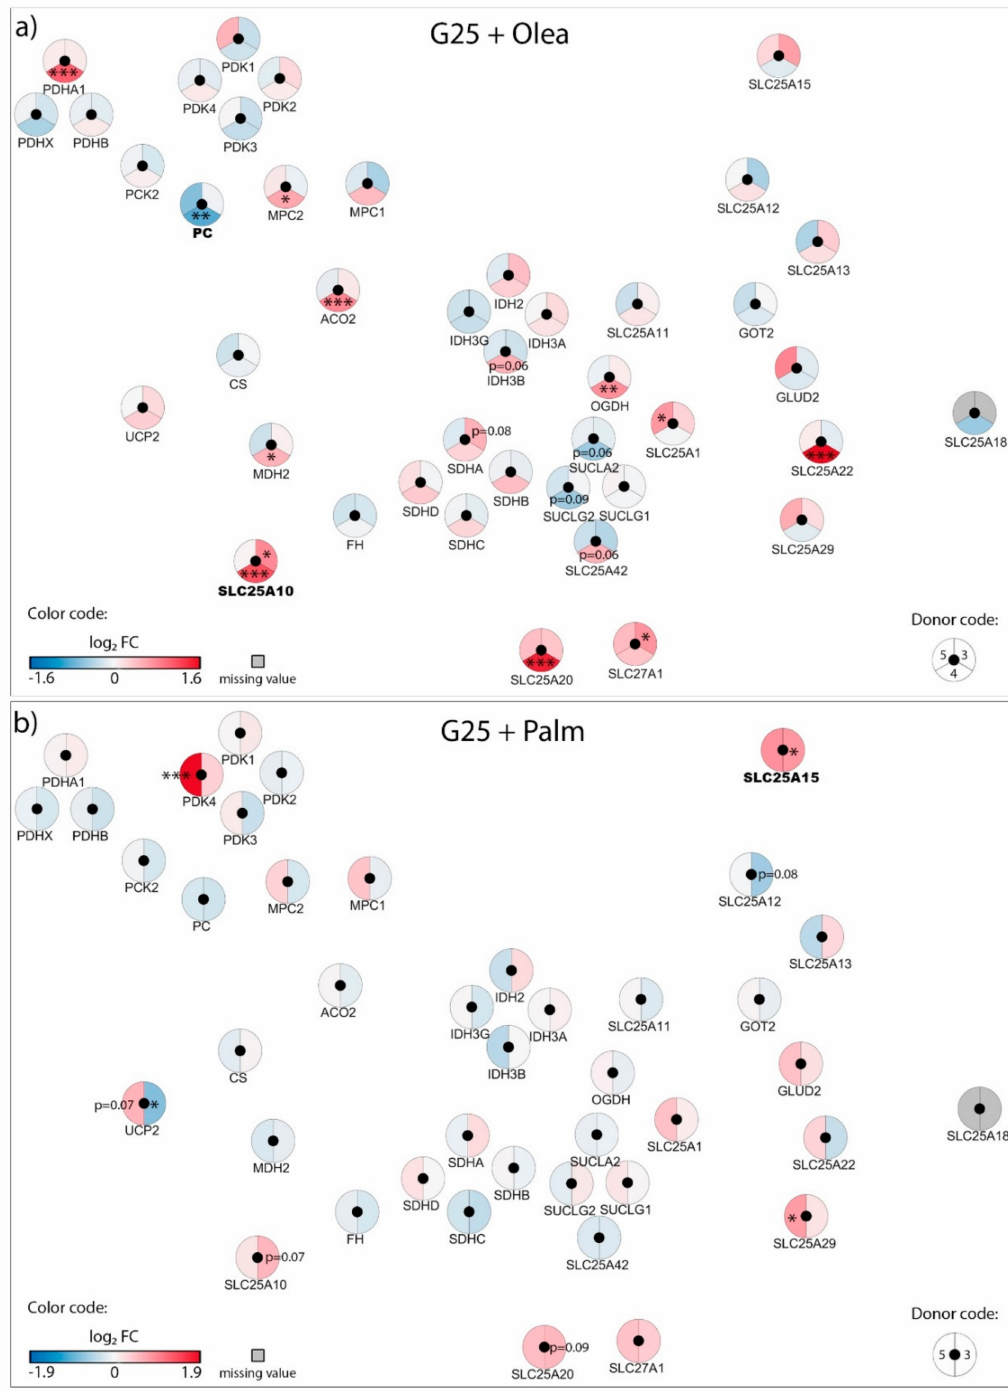
Figure 4. Effects of high 25 mM glucose (G25) plus 0.4 mM oleate (G25 + Olea) or palmitate (G25 + Palm) on the transcriptional regulation of mitochondrial solute carriers and associated genes. Human islets were exposed to ( a ) G25 + Olea or ( b ) G25 + Palm glucolipotoxic conditions for 3 days before RNA-Seq analysis. E ff ects of culture conditions on transcript levels are compared to standard G5.5 medium and shown as upregulated (red), downregulated (blue), or unchanged (white). Missing values are represented in grey. Each disk is split into individual changes for the di ff erent donors. Color code reflects the transcriptional changes in log 2 fold changes (log 2 FC) for that particular gene in individual donors. Clinical data from individual donors are shown in Supplementary Table S1, while quantitative transcriptional data are shown in Supplementary Table S2. * adjusted p < 0.05, ** adjusted p < 0.01, *** adjusted p < 0.001 between control 5.5 mM glucose and the specific culture